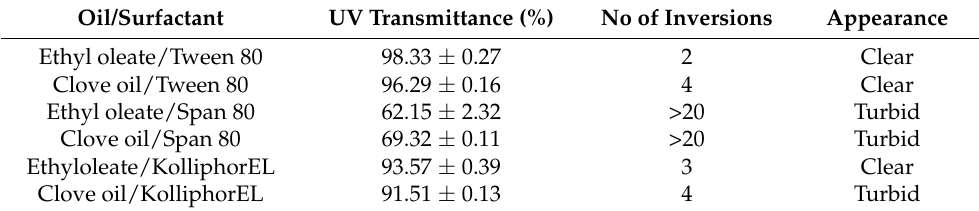
Table 1. Screening of Surfactants via Emulsification Test and %